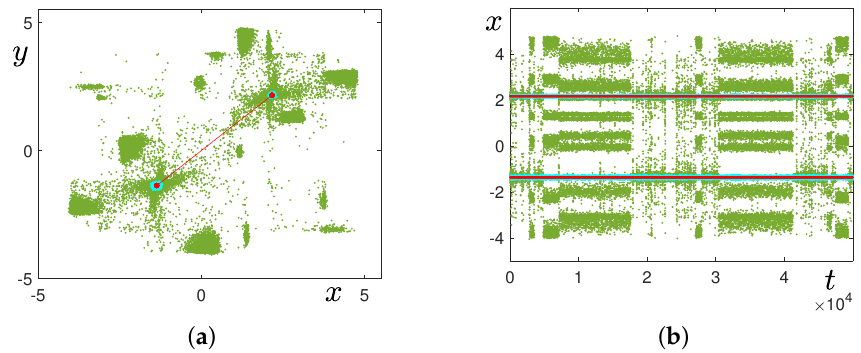
Figure 8. Stochastic system (2) with σ = 0.8 . ( a ) Phase states and ( b ) time series for ε = 0.02 (light blue zones) and ε = 0.03 (green zones). The deterministic in-phase 2-cycle is shown in red.